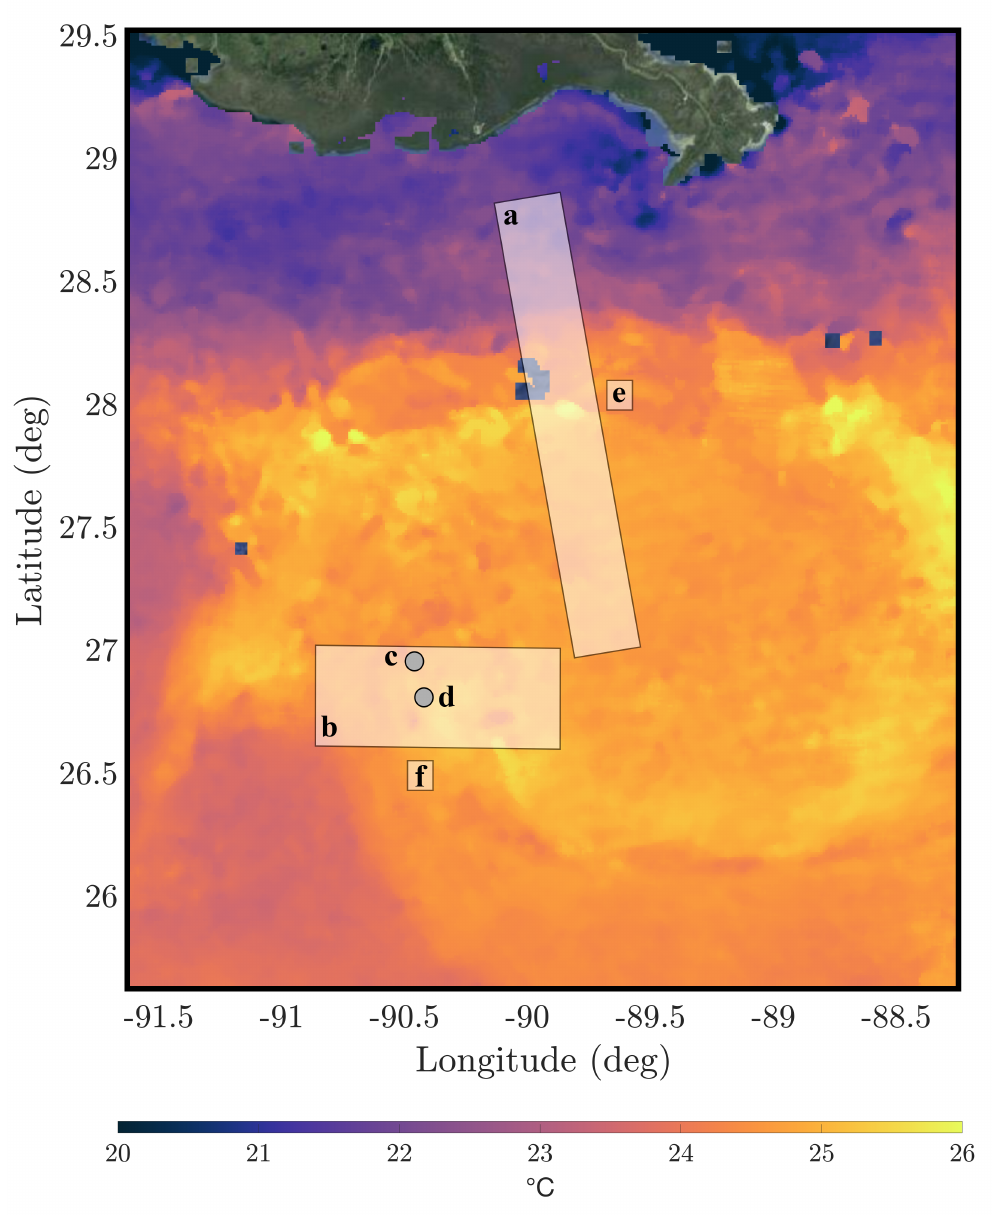
Figure 7. Gridded, interpolated SST as measured by VIIRS over the course of the four-day deployment. ( a ) The North-South DopplerScatt flight region representing the radar ground swath. ( b ) The East-West DopplerScatt flight region. ( c ) Comparison buoy “Fugro” operated and provided by the Chevron Corporation. ( d ) Comparison buoy “NDBC #42360” from the National Data Buoy Center. ( e ) The general area where winds cross perpendicular to the SST eddy jet. ( f ) The general area where the winds cross parallel to the eddy